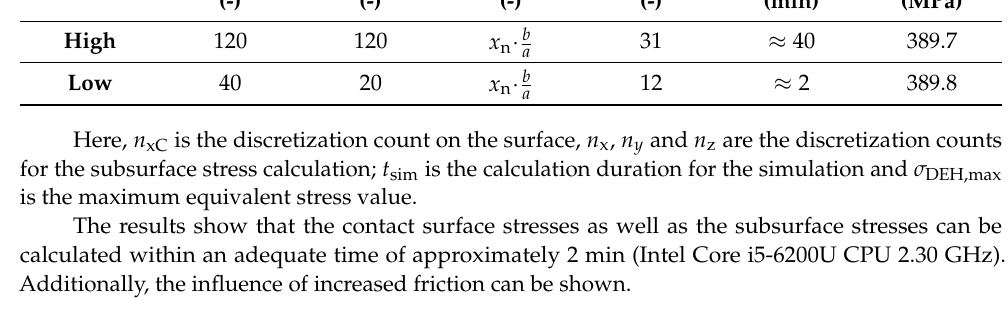
Table 2. Discretization, Duration and Accuracy.